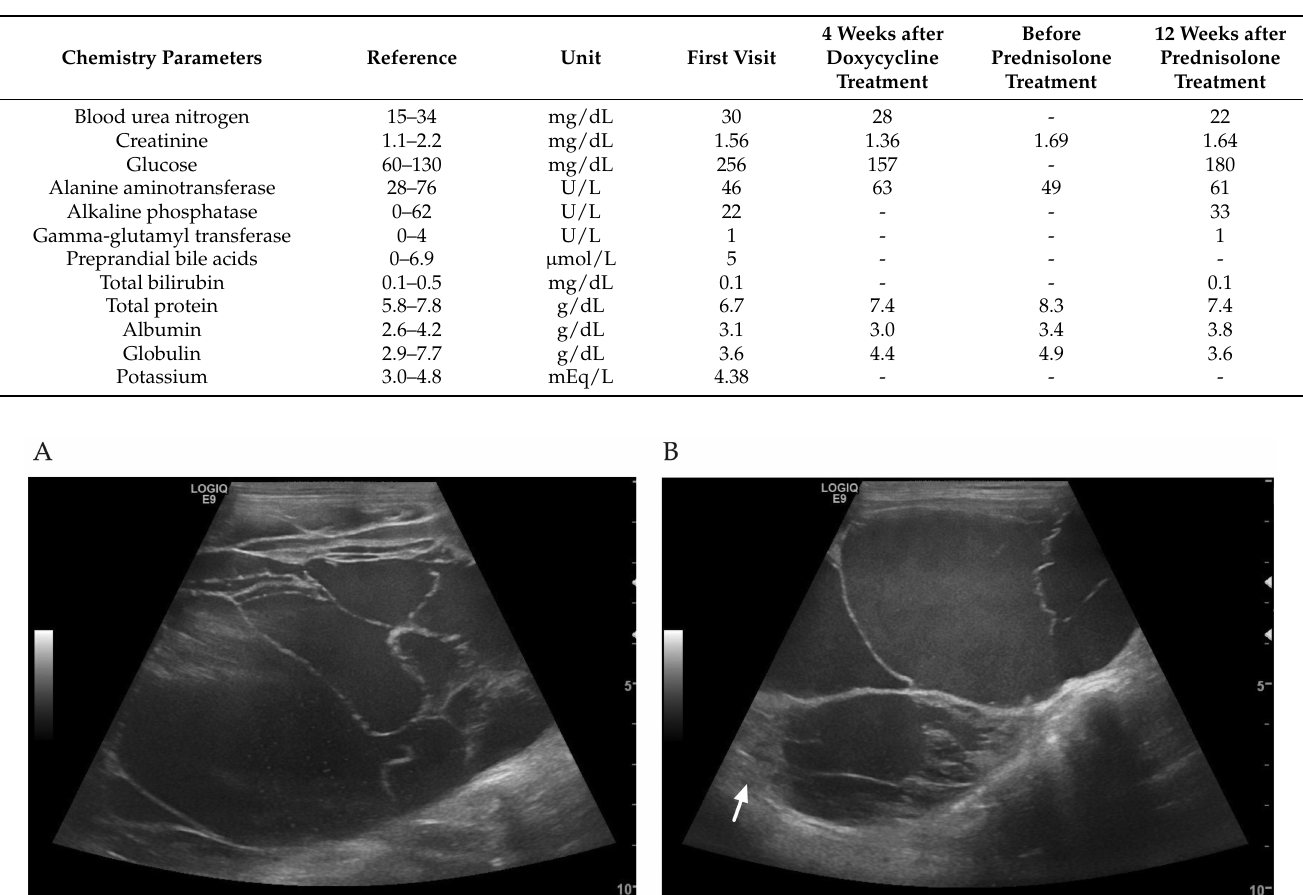
Table 2. Blood chemistry profile at first visit, 4 weeks after doxycycline treatment, before prednisolone treatment, and 12 weeks after prednisolone treatment.